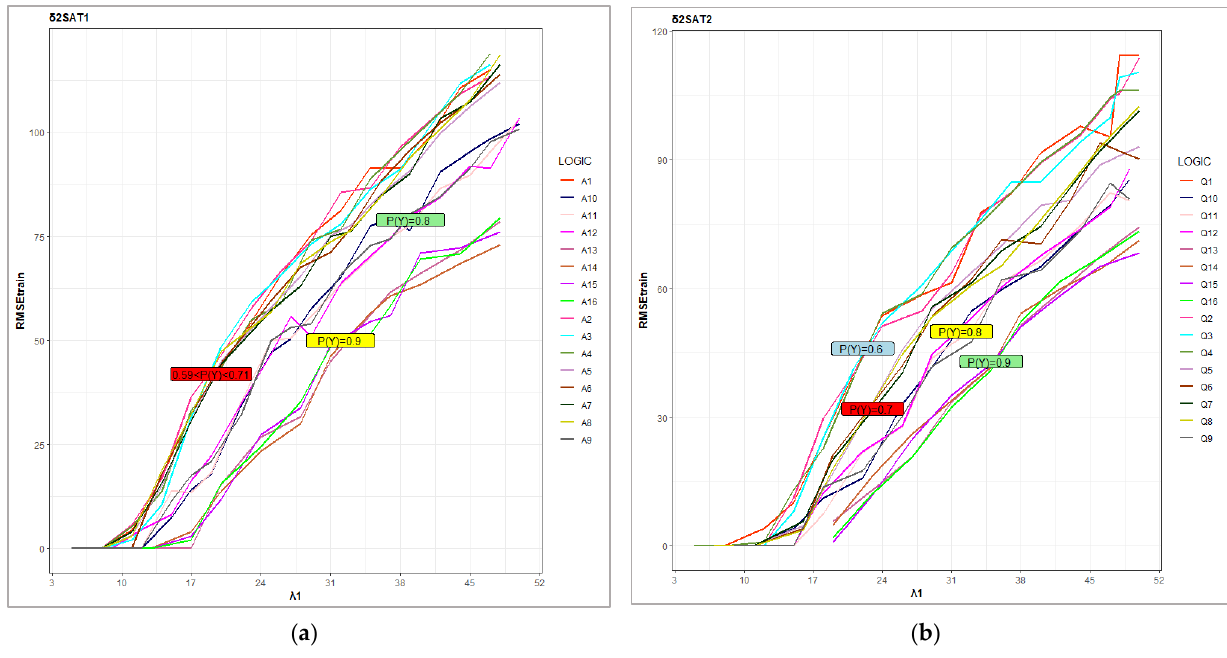
Figure 8. RMSE train line representation for models in both types of logic ( a ) Figure 8. RMSEtrain line representation for models in both types of logic ( a ) δ